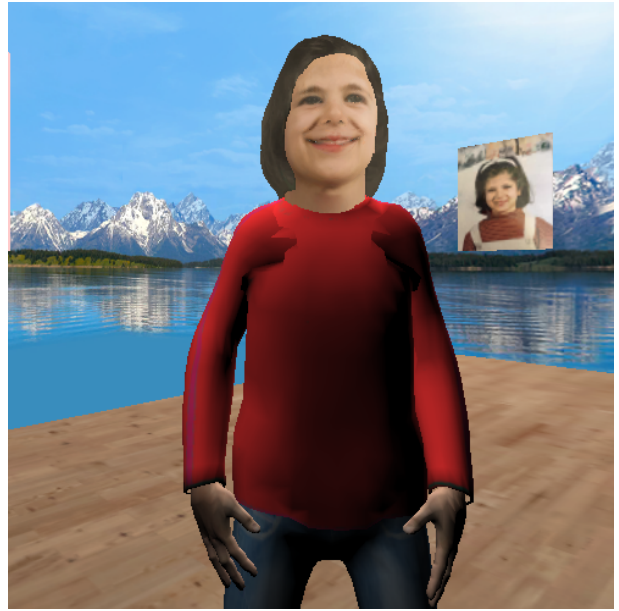
Figure 4. ‘Happy’ emotion animation is presented on a customised avatar (real photo in the